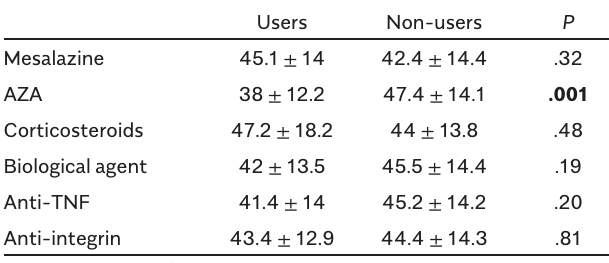
Table 3. The Differences in Mean Age Between Drug Users and Non-users